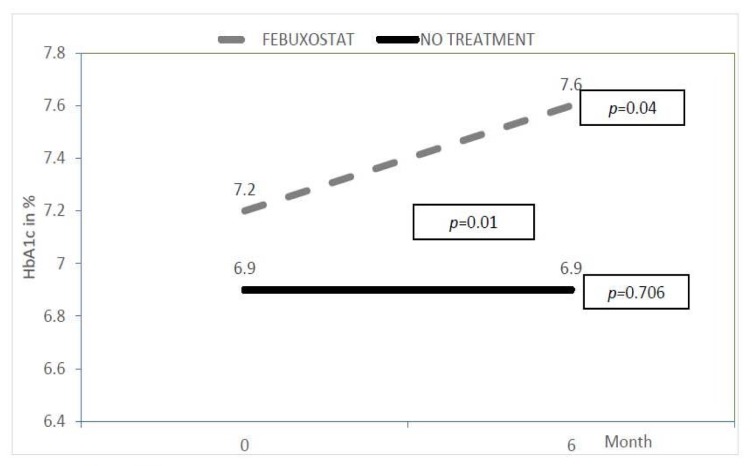
Changes in HbA1c